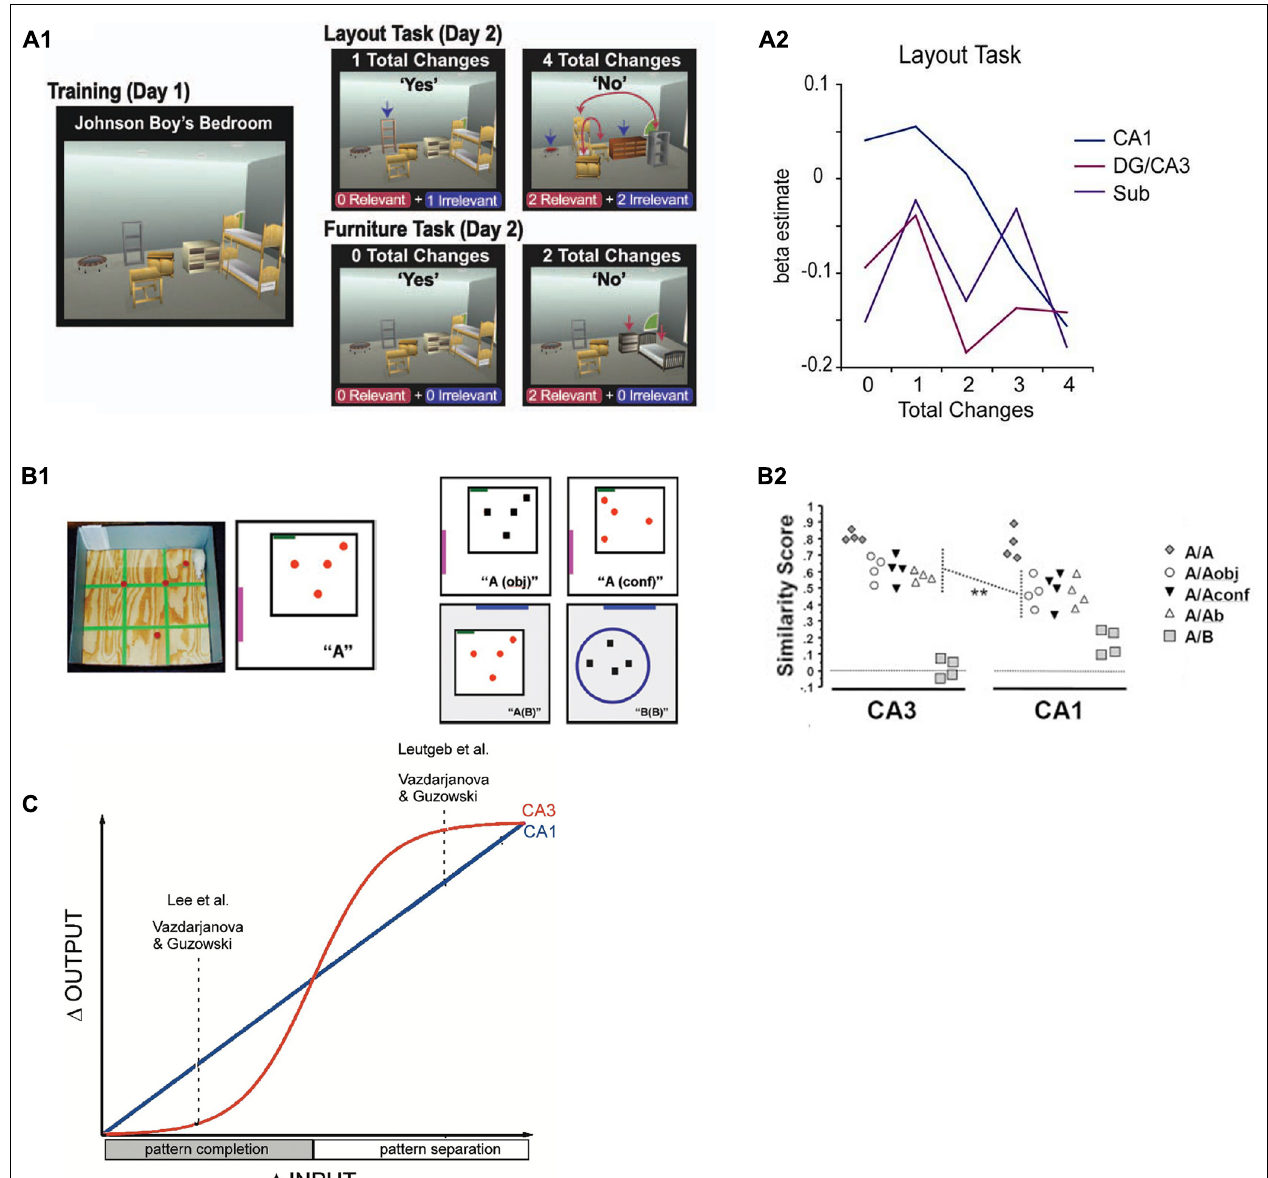
completely different (A/B). Again, CA1 ensembles show linearly decreasing overlap (as captured by a similarity score) with increasing dissimilarity between training and test environment, whereas CA3 ensemble overlap remains fairly high and only drops rapidly in the most dissimilar condition. Reproduced with permission from Vazdarjanova and Guzowski (2004). (C) Schematic depiction of the results of three studies in rodents (Guzowski etal., 2004) in which a similar behavior as found in the Duncan etal. (2012) study is described: CA1 output changes linearly with increasing changes in input patterns, while CA3 changes its output more in a sigmoidal fashion (i.e., when a specific threshold is crossed), indicating a transition between pattern completion and pattern separation. Reproduced with permission from Guzowski etal.